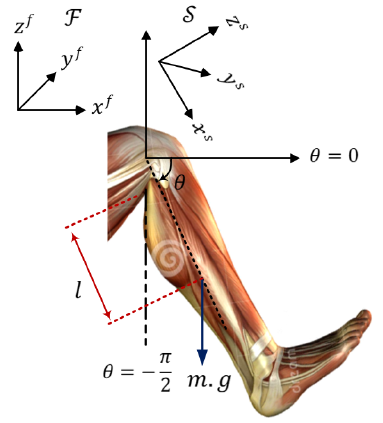
Figure 1. Geometric representation of the exoskeleton knee.